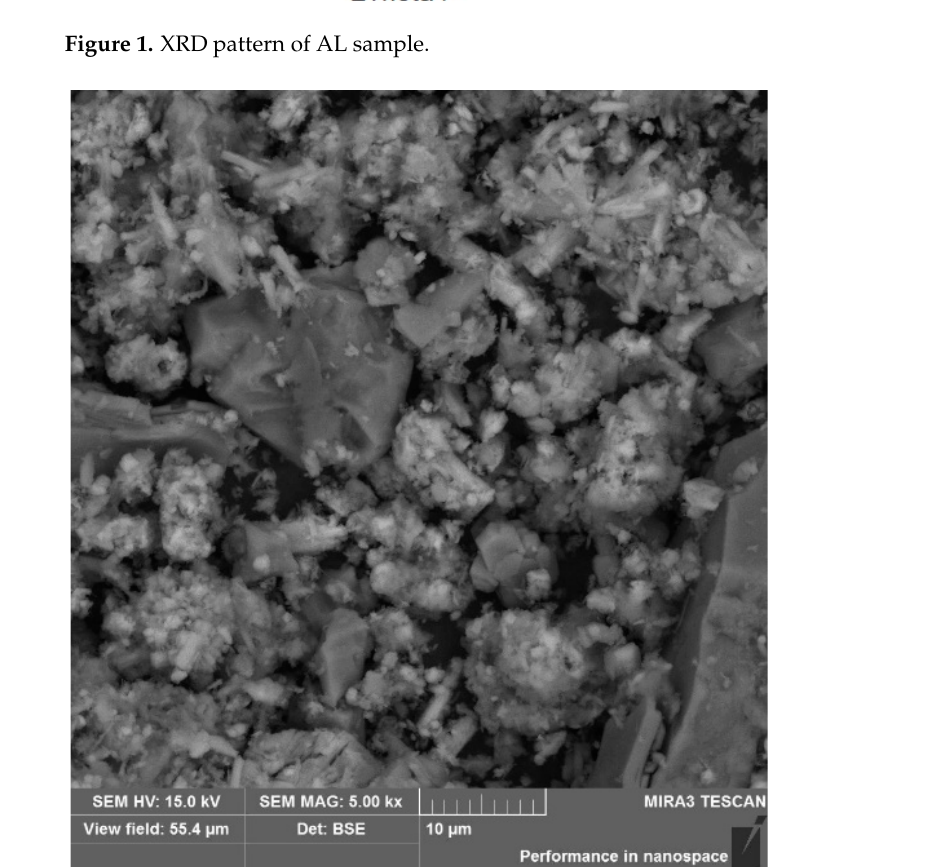
Figure 2. SEM image of AL sample.